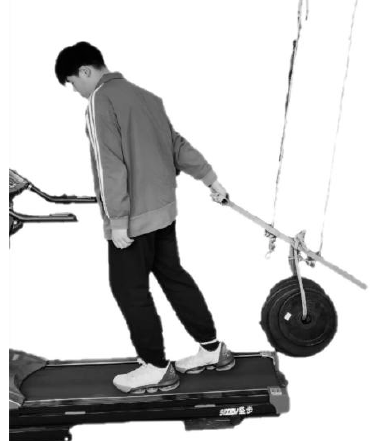
Figure 1. Pulling task on a treadmill.